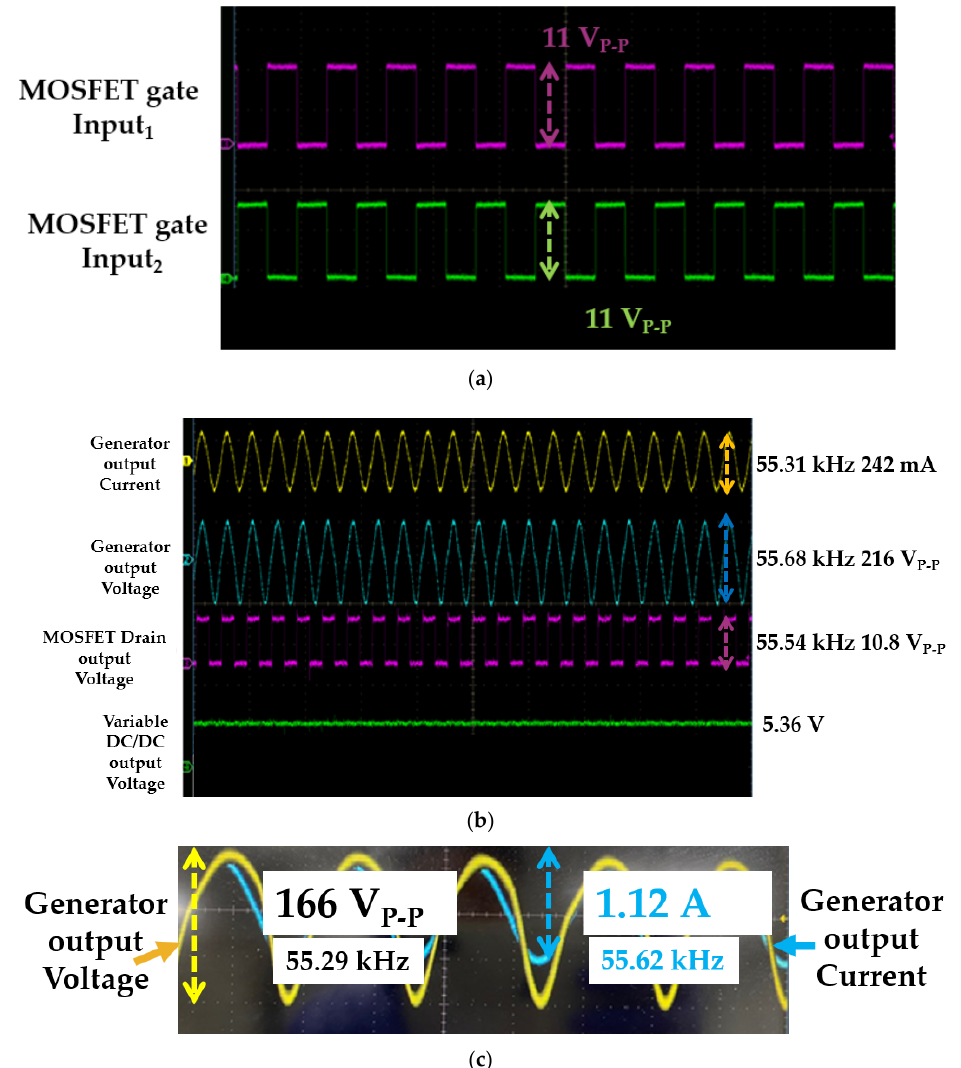
Figure 8. ( a ) Input waveforms of the metal-oxide-semiconductor field-e ff ect transistor (MOSFET) driver, ( b ) output current and voltage amplitudes of the generator instrument before the matching circuit with the MOSFET driver drain output voltage and variable DC / DC output voltage, and ( c ) output current and voltage amplitudes of the generator instrument after the matching